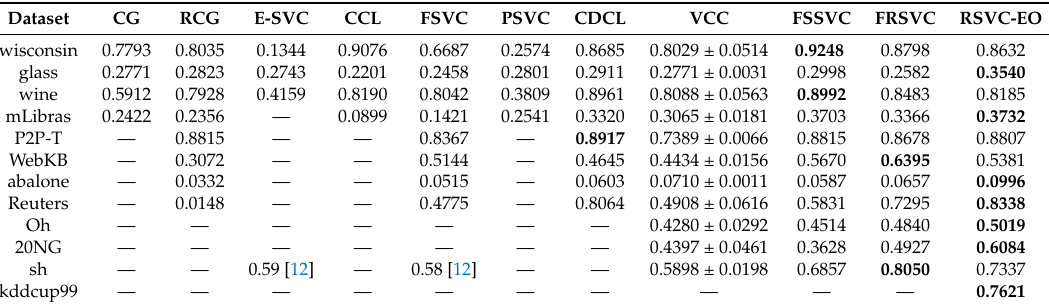
Table 3. Accuracies (ARI) achieved by the state-of-the-art methods on 12 datasets.